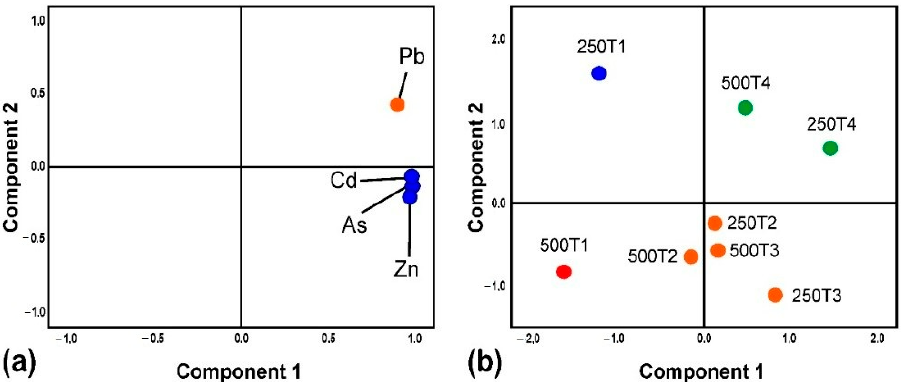
Figure 4. Principal component analysis in the removal of heavy metals, metal cations ( a ) and biosorbents ( b ).